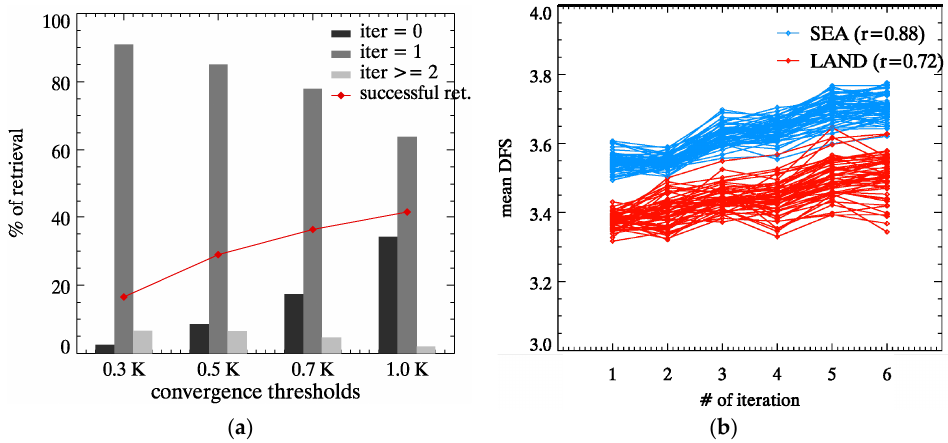
Figure 9. ( a ) the relationship between the convergence thresholds and the percentage of successful clear-sky retrievals ( red line ) and the number of iterations required for the retrieval ( b ) the relationship between the number of iterations and corresponding mean total DFS from 19 different scenes on 1~10 August 2016.